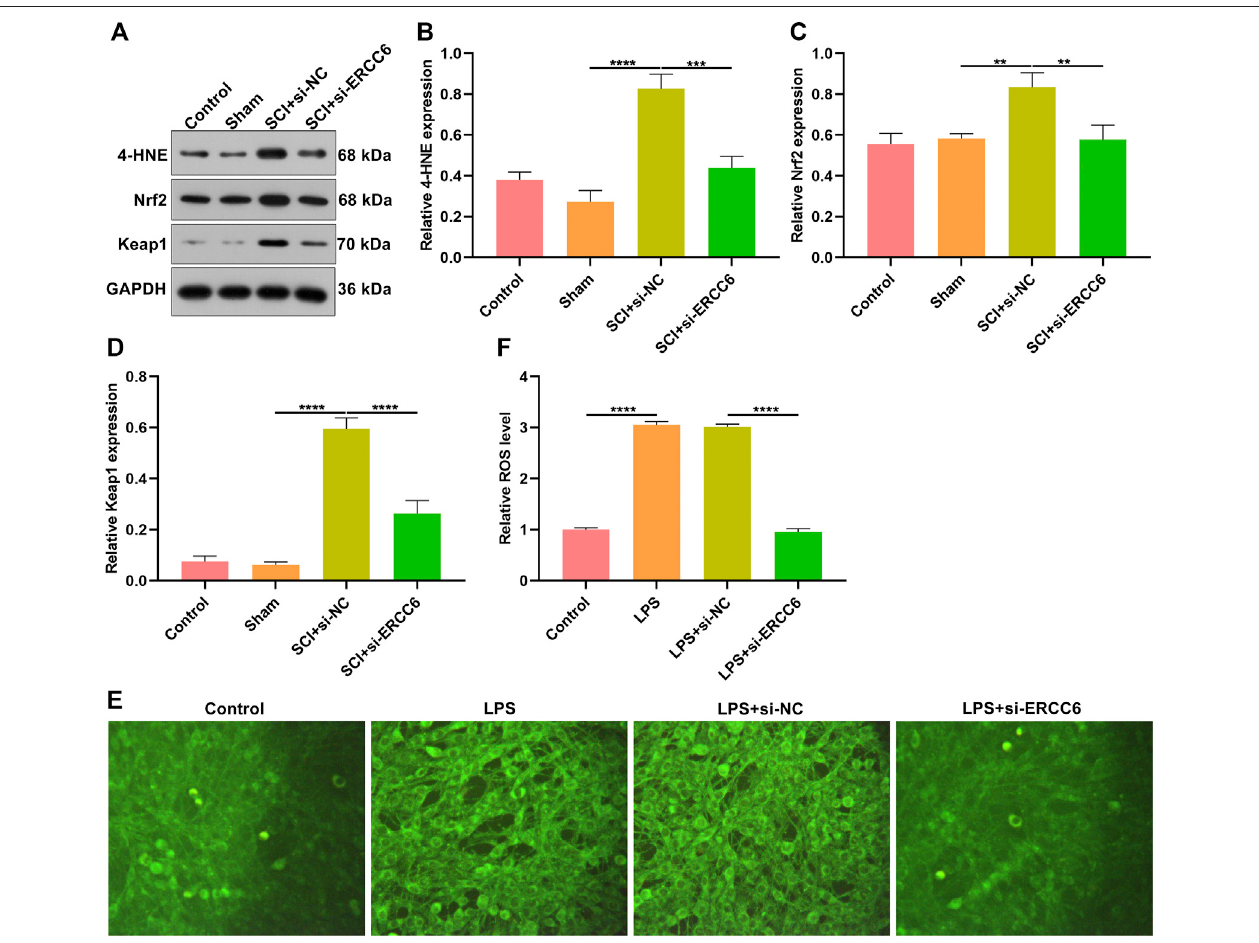
FIGURE 7| ERCC6 ablation alleviatesoxidativestress in the spinal cord ofSCI mice. (A – D) Western blotting analysis ofthe expression of oxidative stress markers 4-HNE, Nrf2,andKeap1 inthespinalcord ofmouse modelsinjected bysi-ERCC6 orsi-NC aswellascontrolandsham operation mice(N=8mice ineachgroup). (E,F) The levels of ROS fl uorescence in LPS-exposed BV2 mouse microglia cells treated with si-ERCC6 or si-NC (scale bar, 50 μ m; N = 3 mice in each group). p -values were calculated with the ANOVA test. ** p -value < 0.01; *** p -value < 0.001; **** p -value <